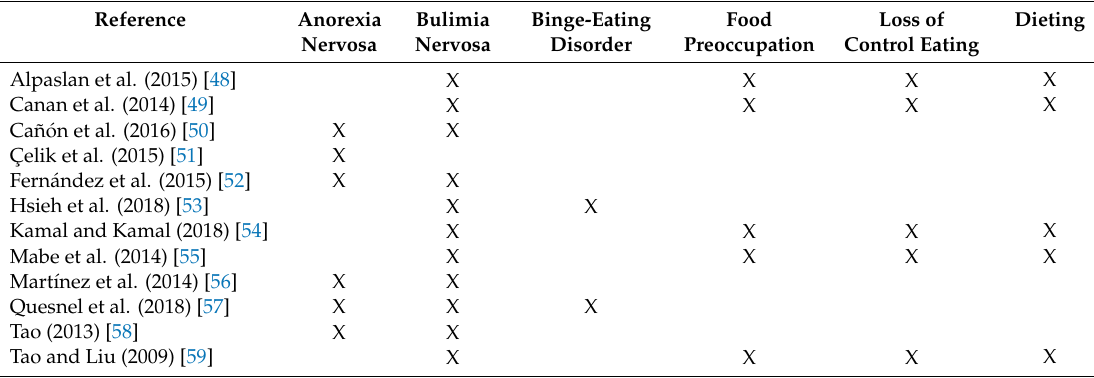
Table 4. Eating disorders associated with each